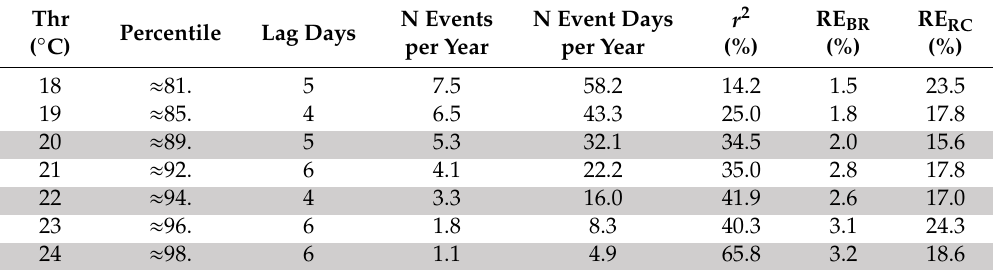
RE RC —relative error of the regression coe ffi cient (slope). Selected regression models are shaded.